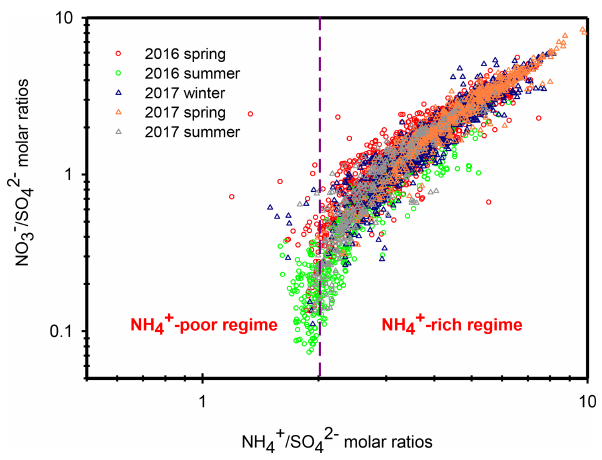
Figure 6. Scatter plots of NO − / SO 2 − against 3 4 tions in Nanjing during the different seasons. The results in Beijing, Shanghai, Guangzhou, Lanzhou and Hong Kong are also shown in this / SO 2 − ( Y ) and 3 4 / SO 2 − in 4 4